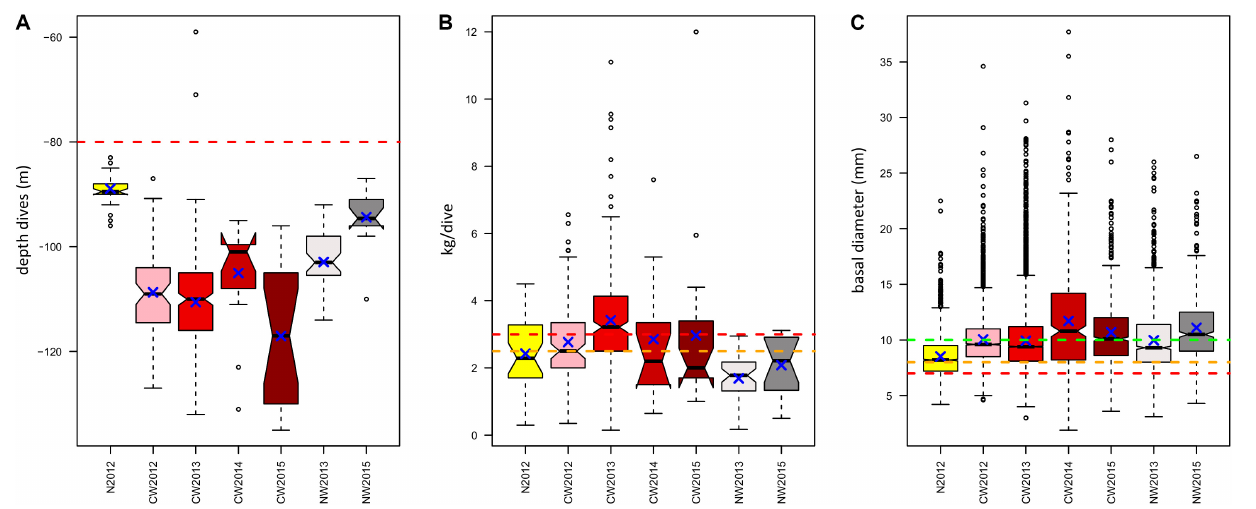
FIGURE 5 | Notched boxplots for the different areas (N, northern coast, CW, central–western coast, NW, northwestern coast of Sardinia) and years: depth of dives (A) , amount (kg) of red coral collected in each dive (B) , and basal diameter (mm) of the harvested red coral colonies (C) . The box shows the interquartile range (IQR), while the whiskers add 1.5 times the IQR to the 75 percentile (Q3) and subtract 1.5 times the IQR from the 25 percentile (Q1). The thick line shows the median of the data, the notch displays the confidence interval around the median, and the blue cross indicates the mean value. The small circles are the outliers. The dashed lines in color (red, orange, and green) indicate the legal limits for collecting red coral in Sardinia (see main text and Supplementary Table S1 for